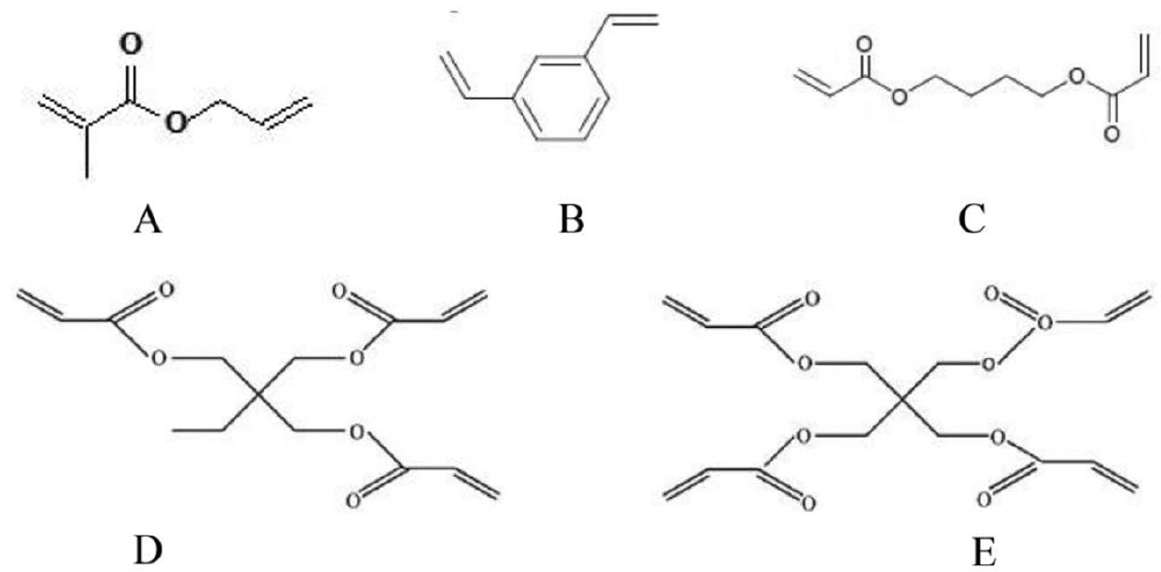
Figure 1: The chemical structure of cross-linking agents: (a) allyl methacrylate (AMA), (b) divinyl benzene (DVB), (c) 1,4-butylene glycol diacrylate (BDDA), (d) trimethylolpropyltriacrylate (TMPTA), (e) pentaerythritol tetraacrylate (PETRA)